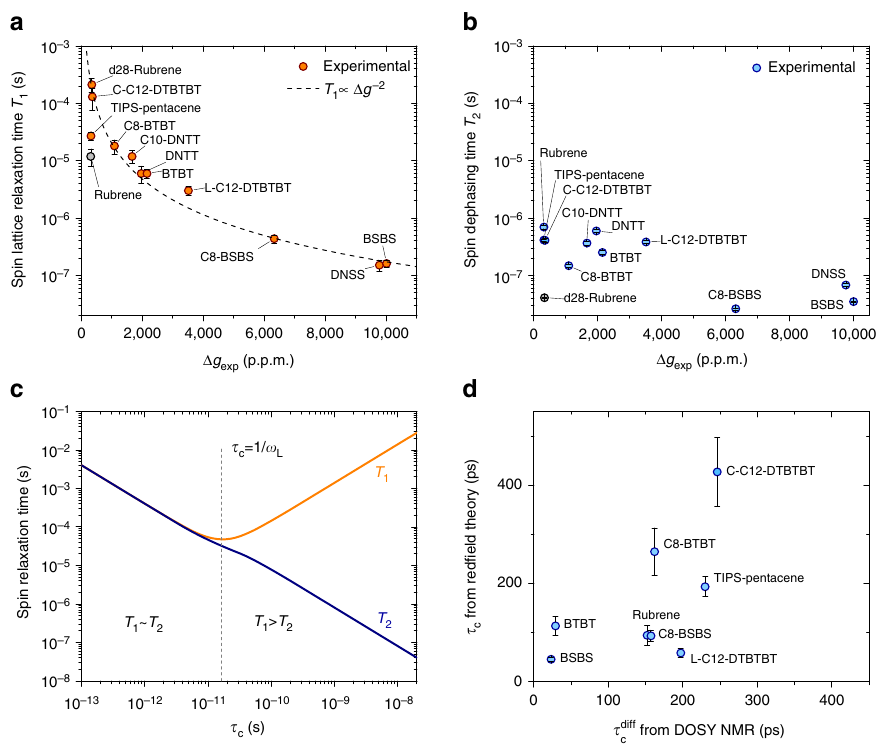
Figure 4 | Dependance of spin relaxation times on the effective SOC. ( a ) Spin lattice relaxation time versus D g for all measured molecules. Error bars represent 95% confidence intervals. Dashed line shows the expected proportionality T 1 p ( D g ) (cid:2) 2 for relaxation via SOC fields. ( b ) Spin coherence time versus D g for all measured molecules. Error bars show the 95% confidence intervals. ( c ) Dependence of T 1 and T 2 on the correlation time t C of field 0 : 2mT were used for the plot. ( d ) Correlation times t C as estimated fluctuations from the Redfield theory. Model values of o L /2 p ¼ 9.4GHz and B 2 x ; y ; z ¼ from the Redfield theory and plotted against rotational correlation times obtained from DOSY NMR diffusion constants (when available). Error bars from 95% confidence intervals of T 1 and T 2 and error